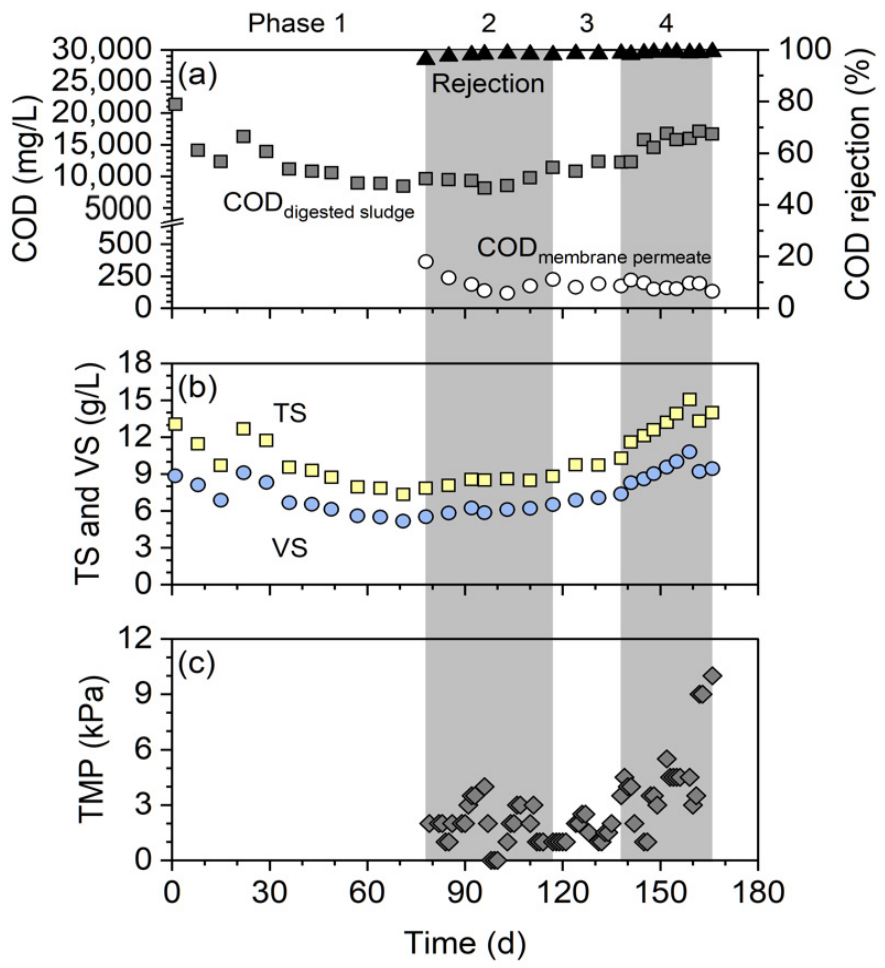
Figure 5. ( a ) COD concentrations in the digested sludge and membrane permeate as well as the COD rejection efficiency by the membrane. ( b ) TS and VS concentrations in the digested sludge. ( c ) TMP of the membrane unit.